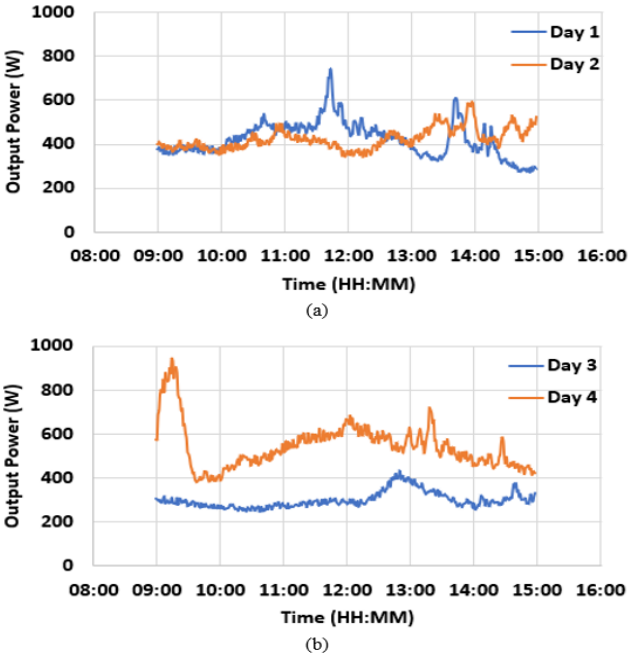
Figure 3. Power measured for the same fault in different ways: ( a ) measurement overlap; ( b ) measurement differences.